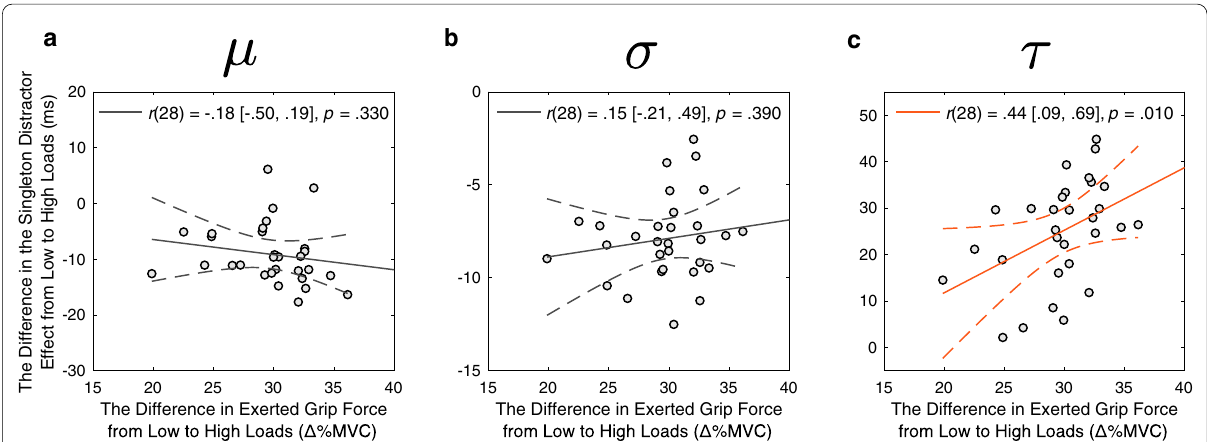
Fig. 4 The interaction effects and the difference in exerted grip force. The difference in the singleton distractor effect from low to high loads (i.e., the interaction effect in Fig. 3d) in τ ( c ), but not in μ ( a ) or σ ( b ), significantly correlated with the difference in exerted grip force from low to high loads (Δ %MVC : high–low load) across the participants. The solid and dashed lines represent the best linear fit and its 95% confidence interval. Pearson correlation coefficient ( r ) with 95% confidence interval and p value are presented in the